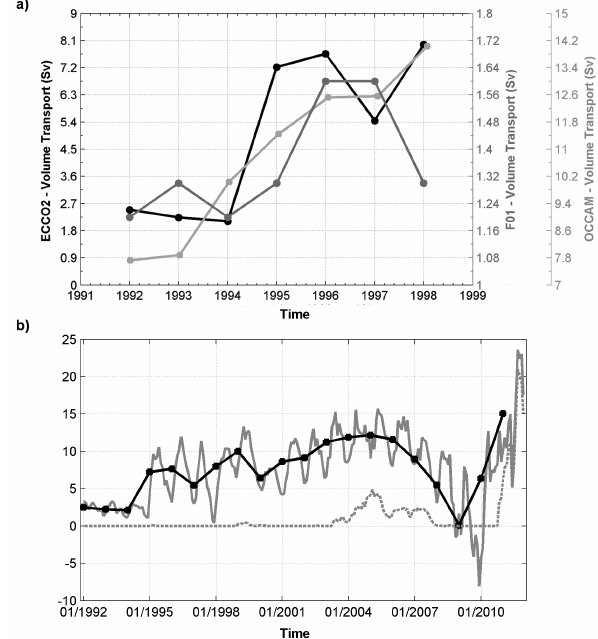
Figure 16. (a) Section II (Fig. 1) annual transport (Sv) based on the ECCO2 (black line), observational (gray line; from Fahrbach et al., 2001) and OCCAM (light gray line; from Kerr et al., 2012) data. The ECCO2 and OCCAM estimates are based on the AABW; (b) ECCO2 Section II annual (black solid line) and monthly (gray solid line) volume transport (Sv) for the AABW layer. Monthly time series considering the WSBW layer are also presented (gray dashed